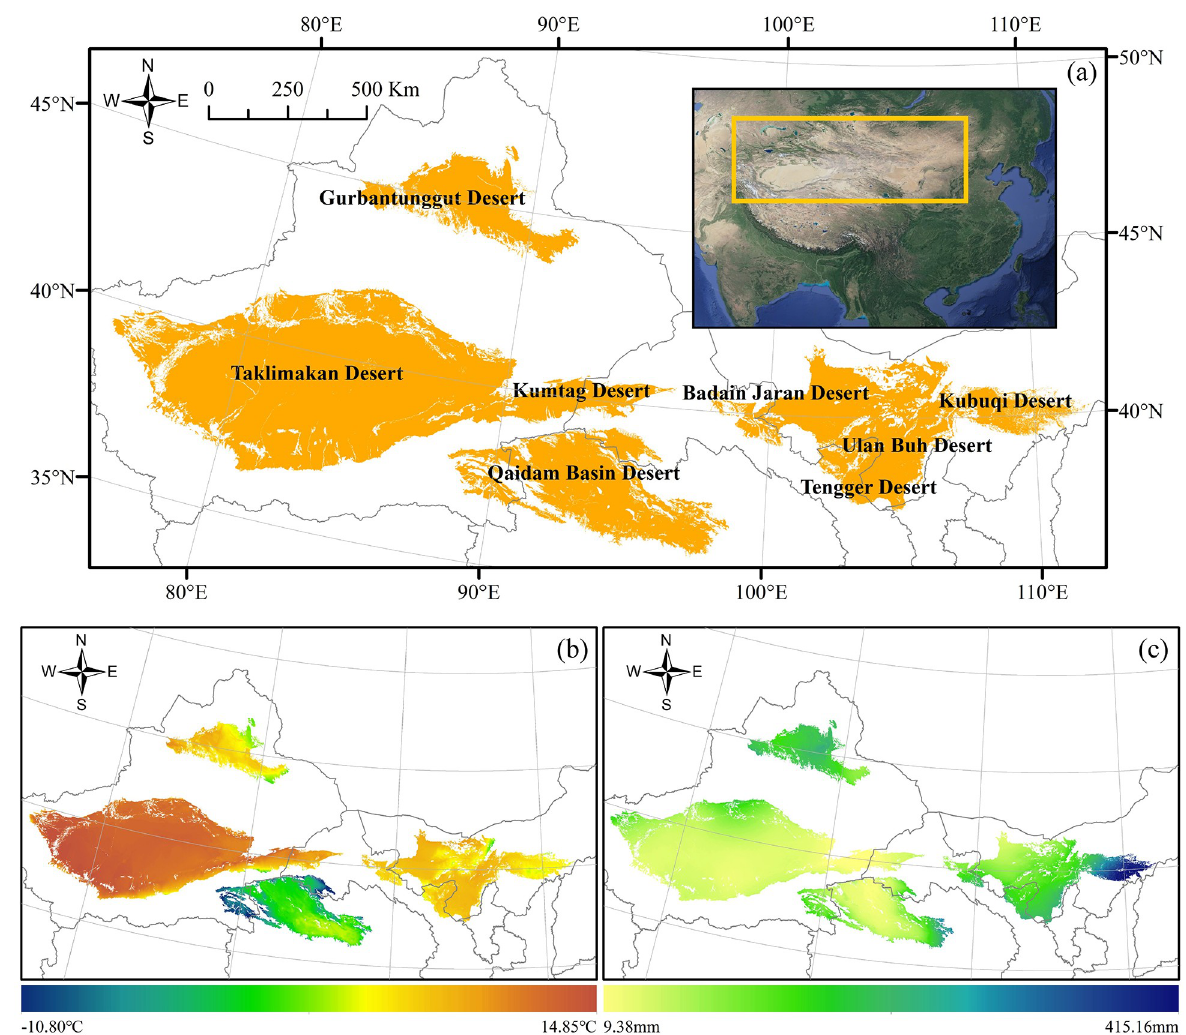
Fig 1. Spatial distribution of deserts in China(a), and mean annual temperature(b) and precipitation(c) of China’s deserts from 2000 to 2017.